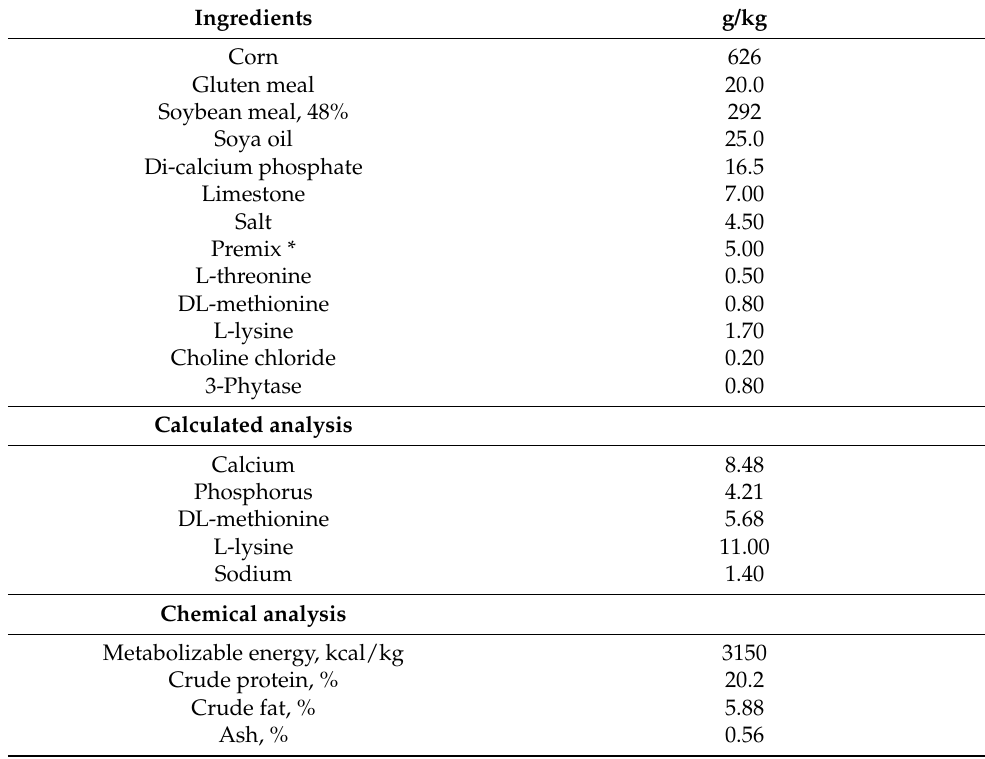
Table 2. Ingredients and nutrient composition of the basal diets fed from days 20 to 35 of age. Ingredients g/kg Corn 626